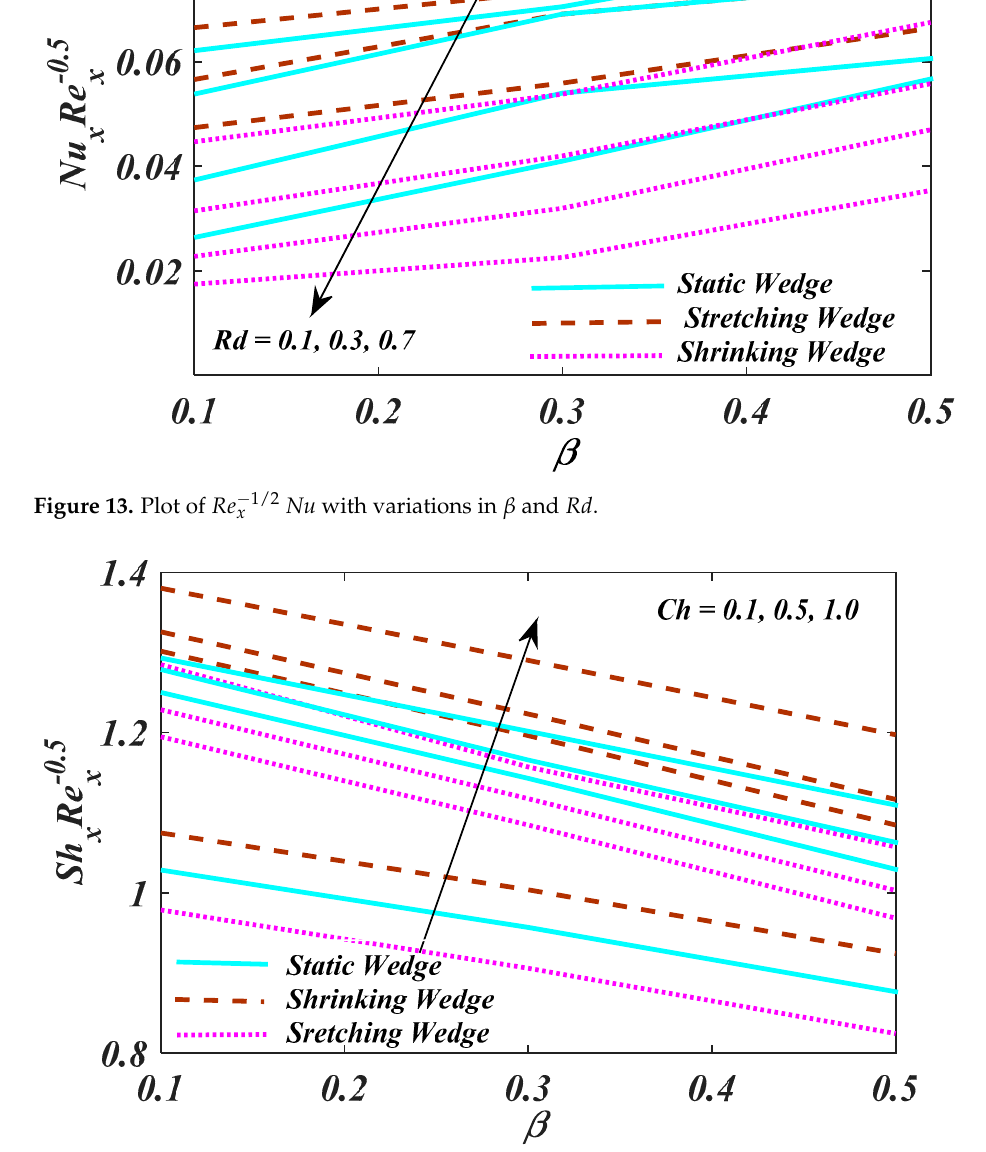
Figure 14. Plot of (cid:1844)(cid:1857) (cid:3051)(cid:2879)(cid:2869)/(cid:2870) (cid:1845)(cid:1860) with variations in (cid:2010) (cid:1853)(cid:1866)(cid:1856) (cid:1829)(cid:1860) . Figure 14. Plot of Re − 1/2 x Sh with variations in β and Ch